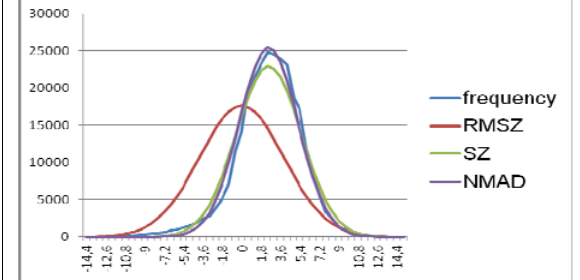
Figure 5: frequency distribution of discrepancies of ACE2 GDEM against reference DEM in open areas and normal distribution based on RMSZ, SZ and NMAD, test area Warsaw These both test areas show the general trend for the mentioned 3 height models, confirmed by other test areas. ACE2 GDEM has advantages in overall areas including forest; nevertheless the relative accuracy is not optimal because of only partial correction (figure 4). In open areas ACE2 GDEM sometimes has the advantage of lower bias, caused by height correction, but without the bias SZ and NMAD are better for